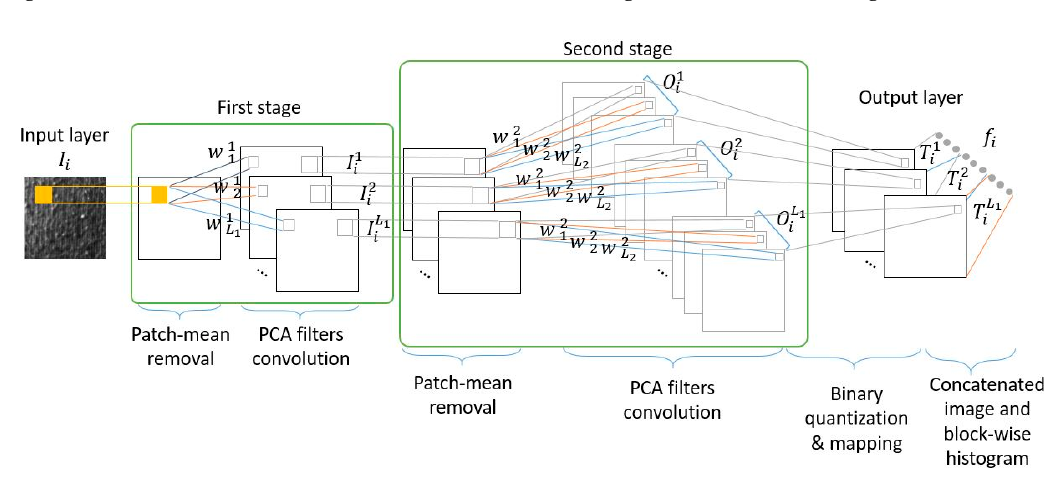
Figure 1. The proposed deep principal components analysis-based neural network (DPCANN) process for fabric pilling evaluation.